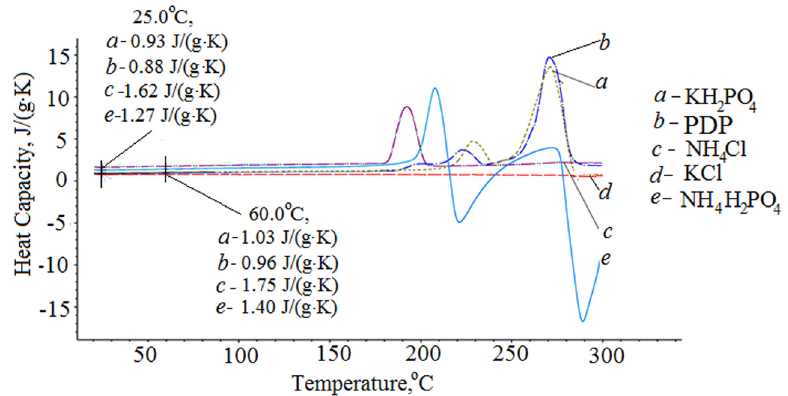
Figure 2: Heat capacity dependence on temperature.